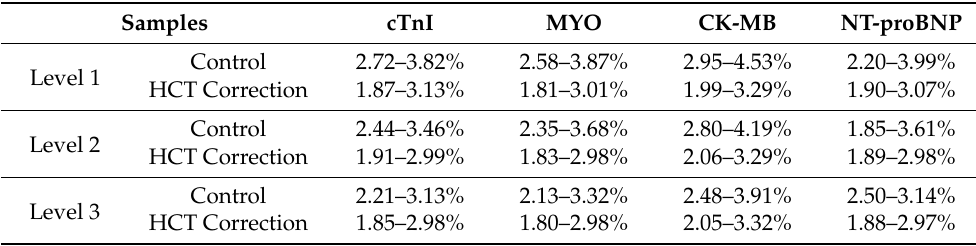
Table 1. cTnI/MYO/CK-MB/NT-proBNP detection repeatability of whole blood samples at 95% con- fidence